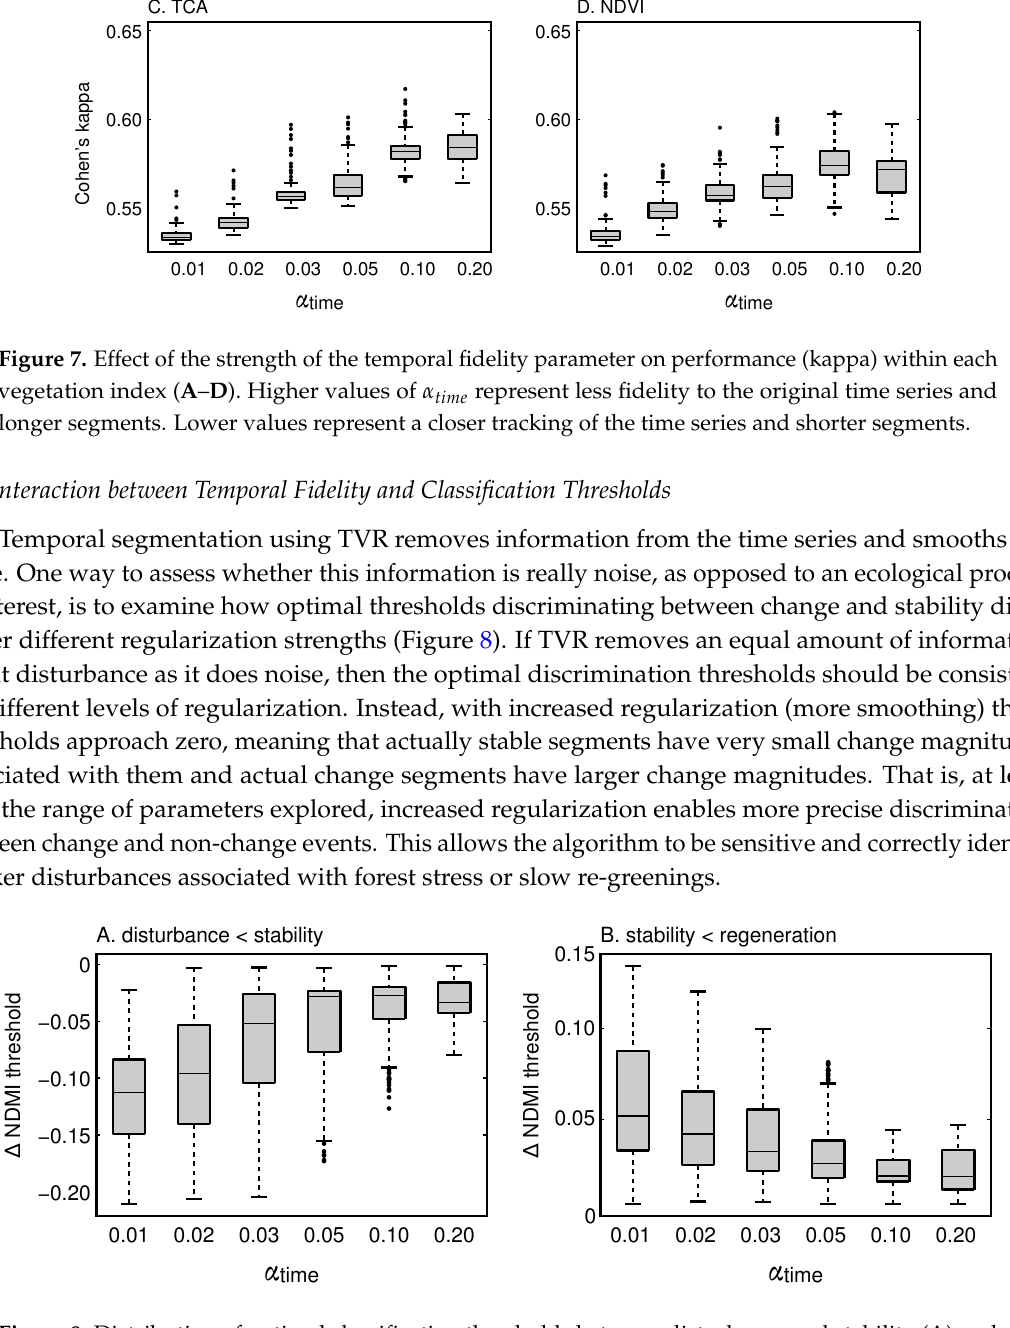
Figure 8. Distribution of optimal classification thresholds between disturbance and stability ( A ) and stability and regeneration ( B ) by amount of simplification applied to the original temporal